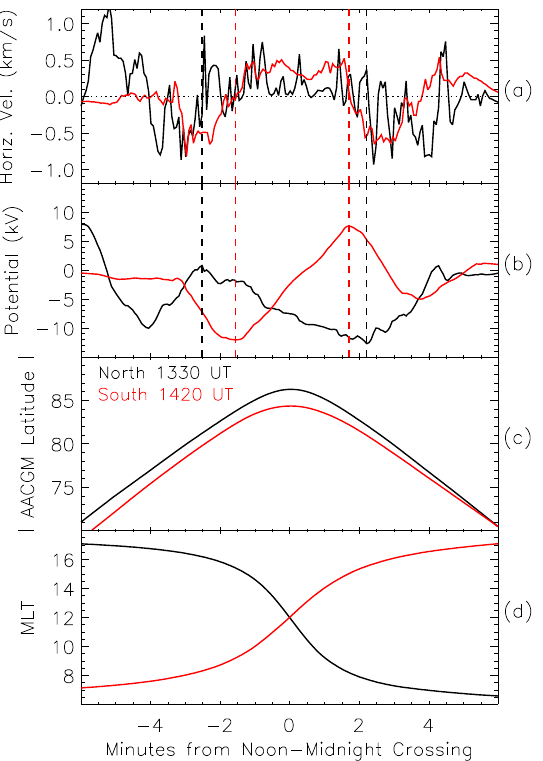
Fig. 4. Data from consecutive DMSP-F13 overpasses of the North- ern Hemisphere polar ionosphere (black lines) centred at 13:30 UT, and the Southern Hemisphere polar ionosphere (red lines) centred at 14:20 UT: ( a ) the horizontal cross-track ion drift volocity, ( b ) the potential variation, ( c ) the AACGM latitude of the spacecraft, and ( d ) the MLT of the spacecraft. The vertical black and red dashed lines delineate the extent of the sunward flow regions and define the approximate centres of the reverse convection